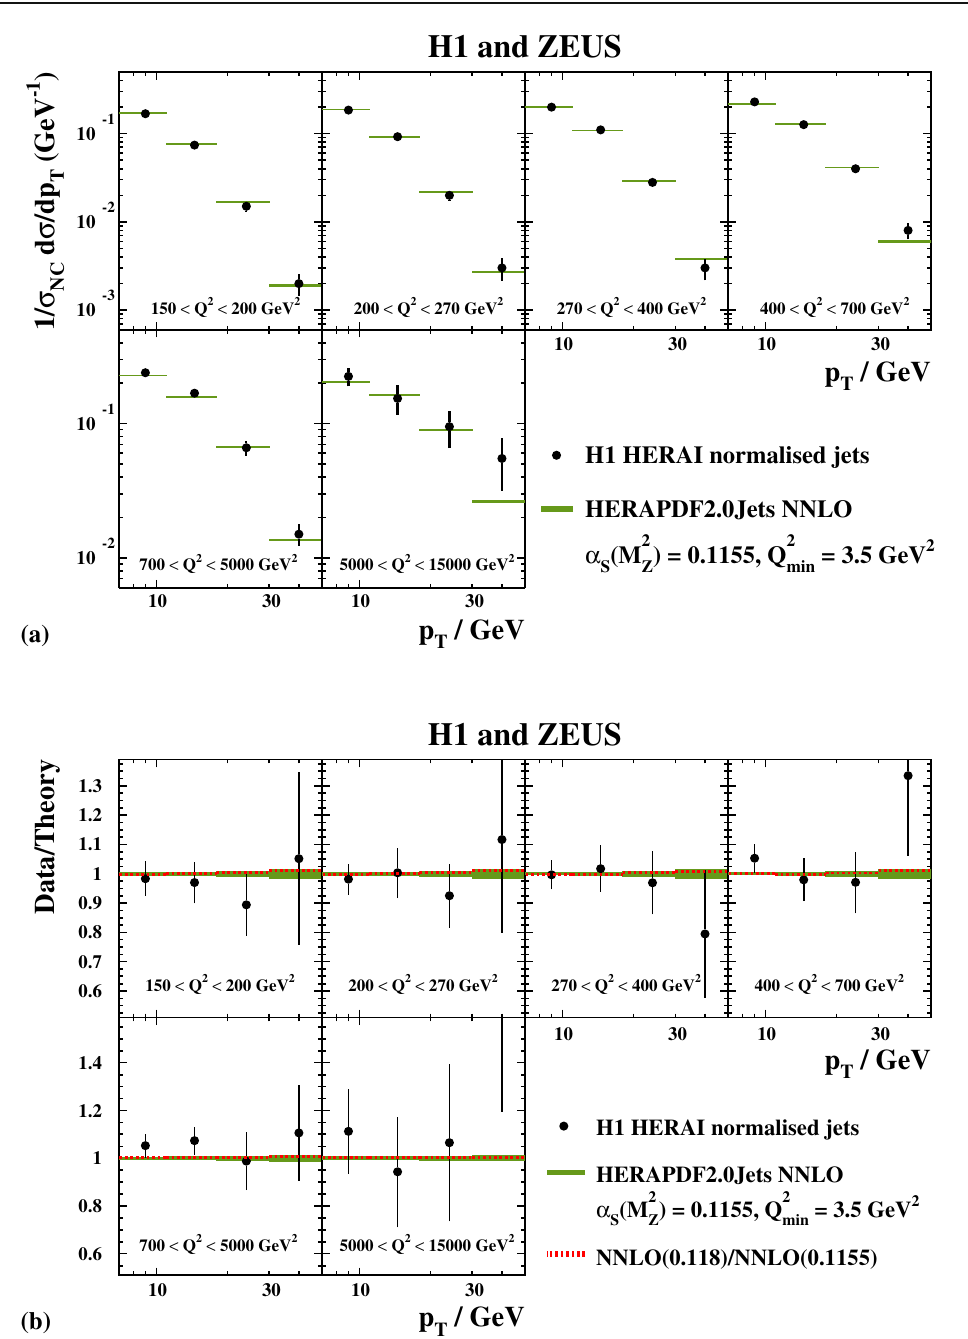
Fig. 14 a Differential jet-cross-section predictions, d σ/ d p T , based on HERAPDF2.0Jets NNLO with α s ( M 2 between 150 and 15,000GeV 2 compared to H1 data normalised to neu- tral current (NC) inclusive cross sections [9]. Only data used in the fit are shown. b Measured normalised cross sections divided by predic-